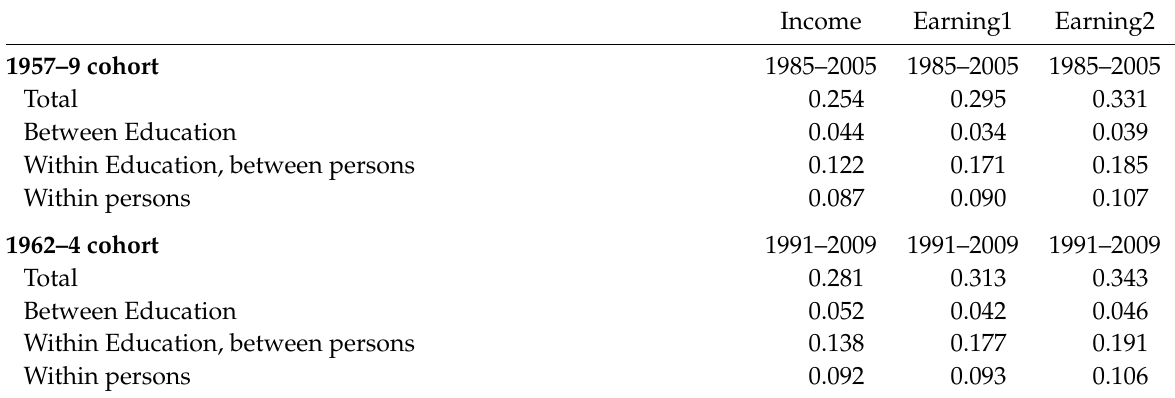
Table 7: Decompositions of Inequality Using Income and Two Measures of